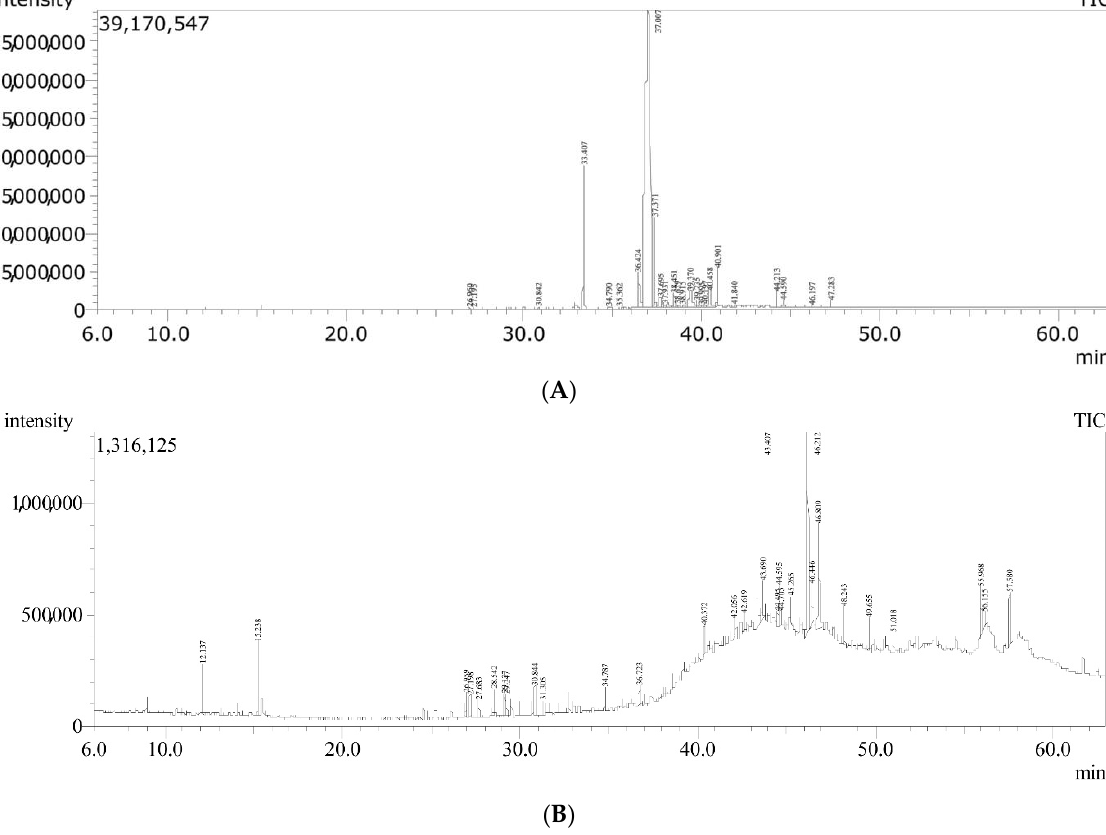
Figure 1. Total ion chromatograms (TICs) of GC-MS/MS analysis of hemp seed oil working sample: ( A ) TIC of saponifiable matter, ( B ) TIC of unsaponifiable matter.